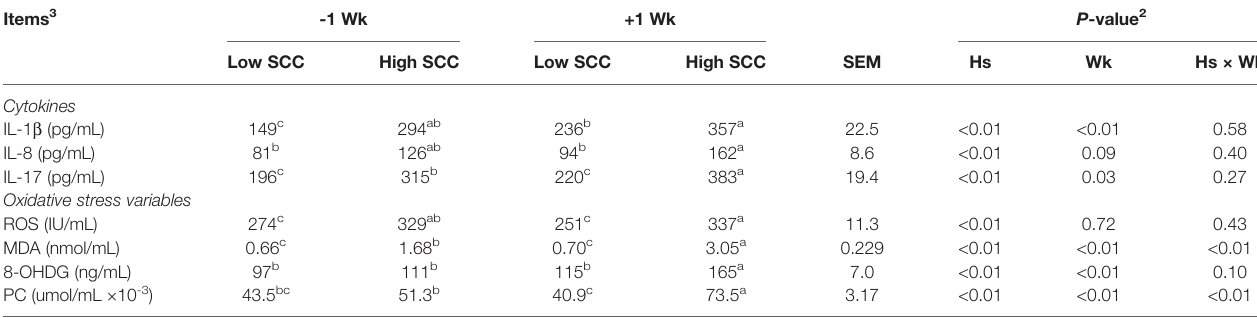
TABLE 1 | Serum concentrations of cytokines and oxidative stress variables in dairy cows with low and high milk somatic cell counts (SCCs) 1 at Week 1 pre- (-1 Wk) and postpartum (+1 Wk). Items